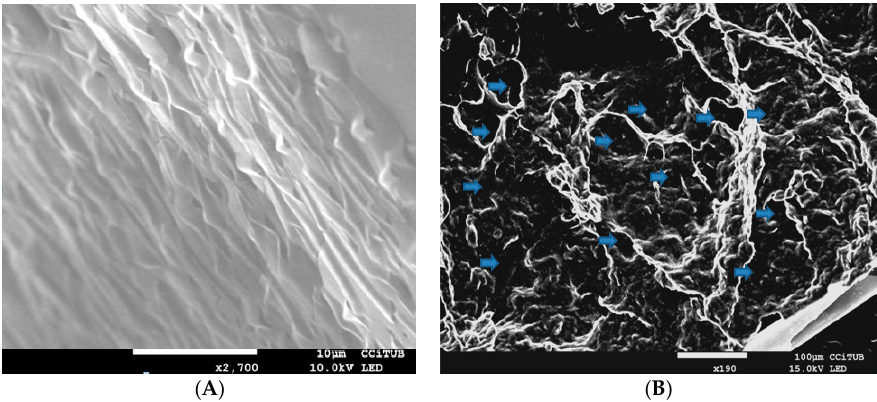
Figure 1. SEM images of the meglumine antimoniate (MA) gel, ( A ) laminar disposition (2700×) and ( B ) porous structure (190×).